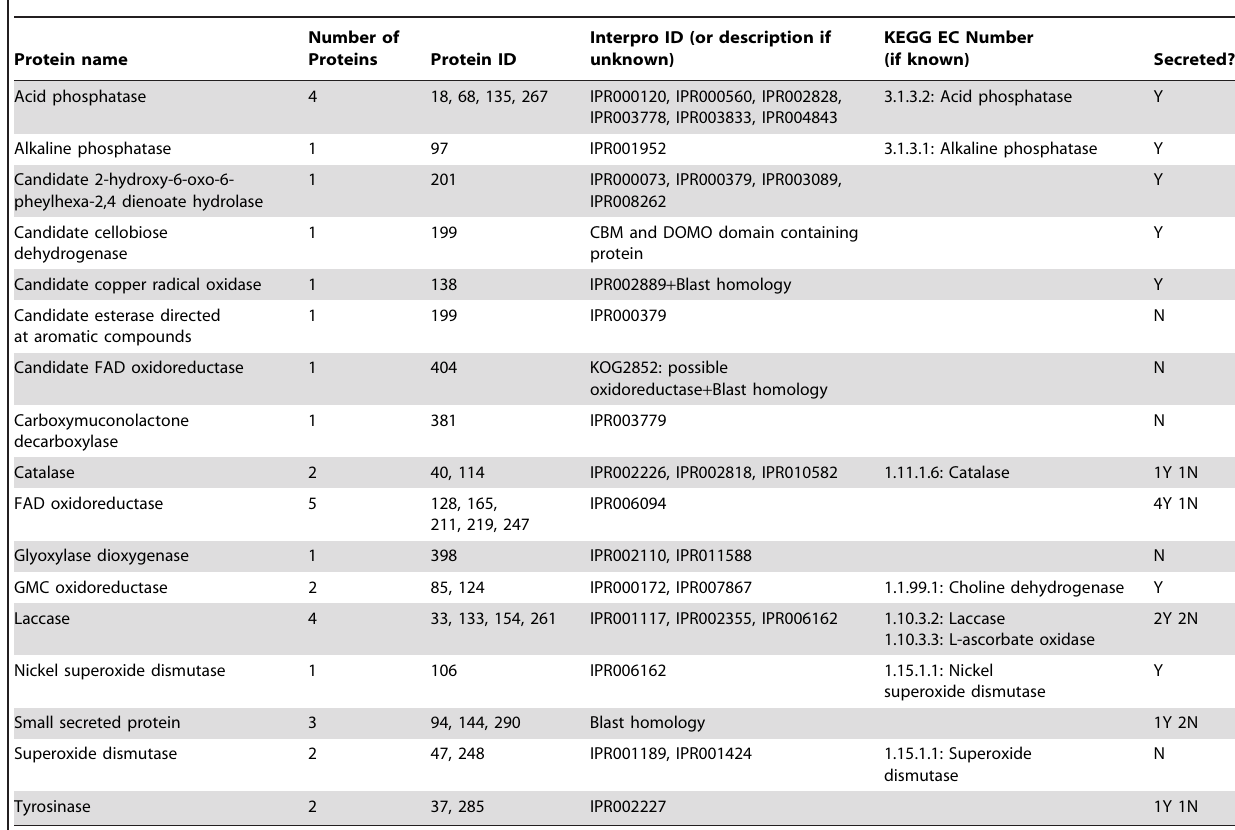
Table 5. Proteins associated with lignin metabolism from MudPIT analysis.